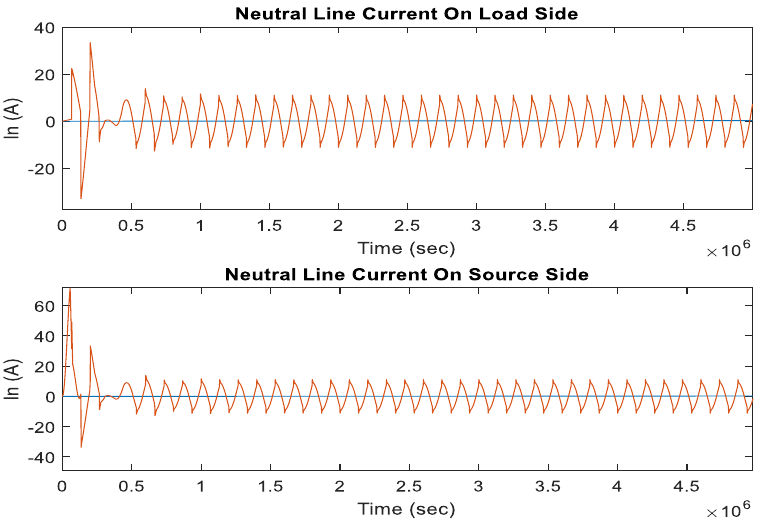
Figure 25. Neutral Line Current without Any Harmonic Filter. After this analysis, the design and implementation of the hybrid harmonic filter are then performed as the next